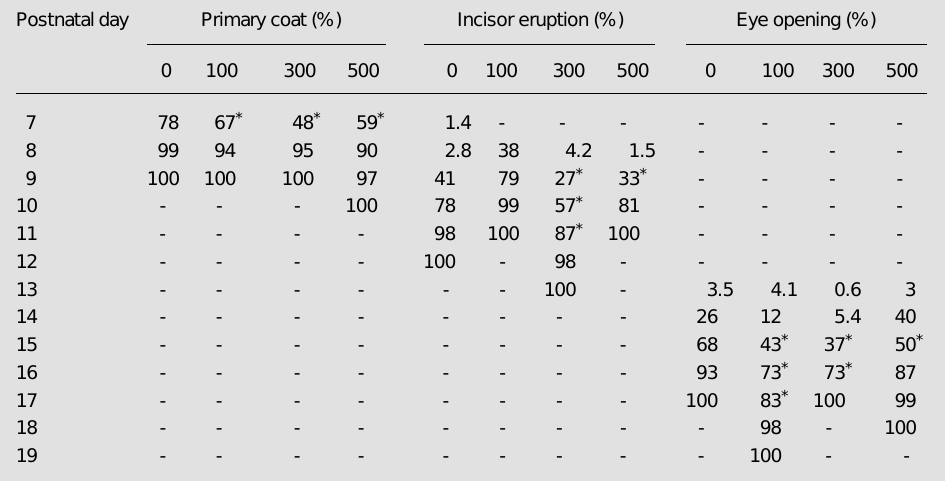
Table 7 - Physical signs of postnatal development of offspring of rats treated orally with ß-myrcene (0, 100, 300 and 500 mg/kg body weight). *P<0.05 compared to controls (chi-square